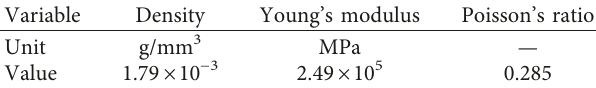
Table 5: Variables of the FRP material model. Variable